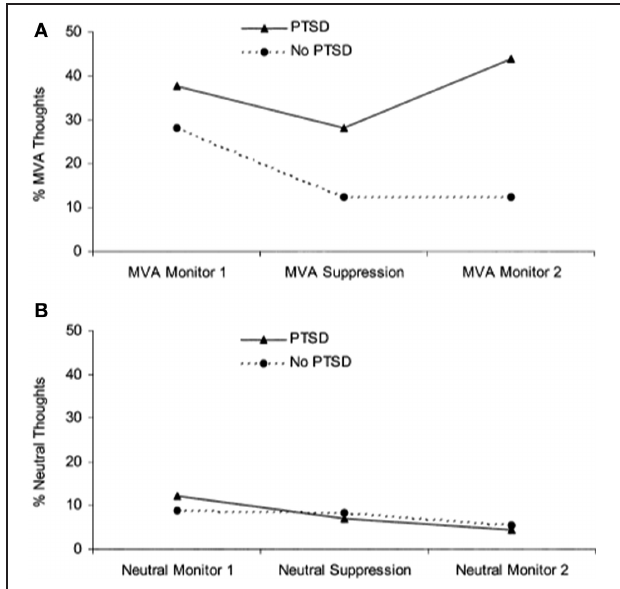
FIGURE 3 | Performance on a thought suppression task. (A) Patients with PTSD reported more trauma-related (i.e., motor vehicle accident, MVA) thoughts after engaging in thought suppression, showing a “rebound” effect. ( B ) Participants did not show a rebound effect for neutral thoughts. Reproduced with permission from Shipherd and Beck